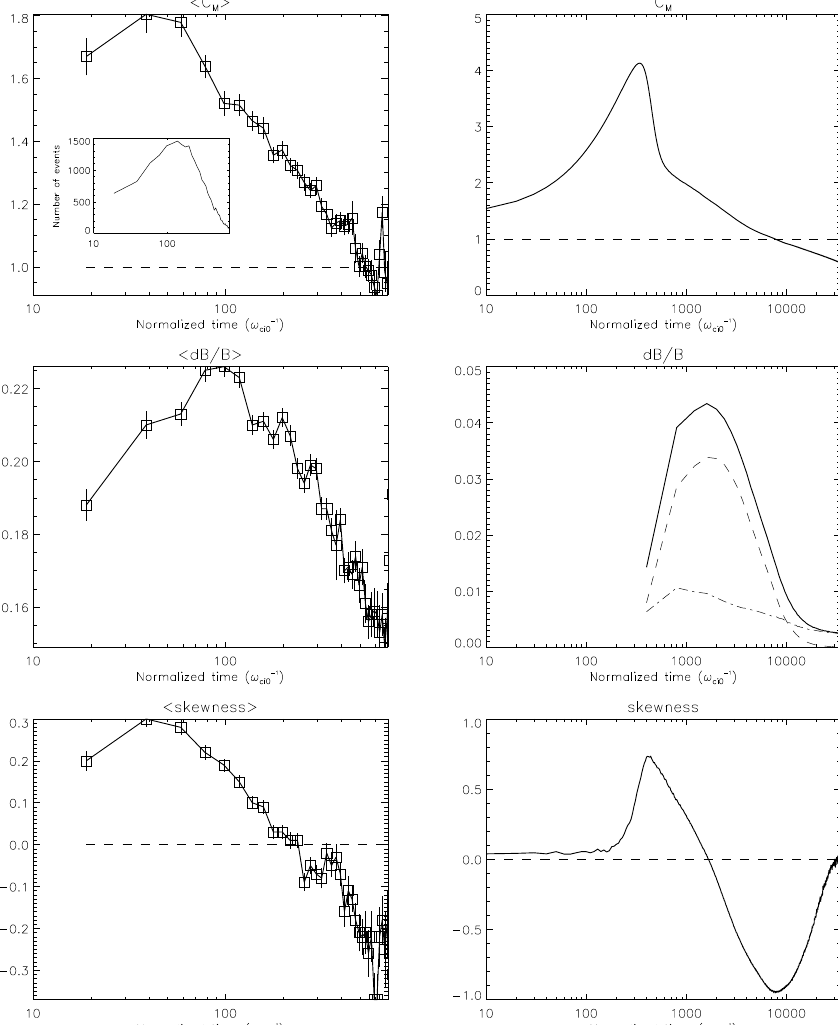
Fig. 4. Left column, observations. As a function of the normalized flow time: (top) median value of C m , (middle) median value of δB/B , (bottom) median value of the skewness. The error bars are proportional to σ/ √ N where σ is the standard deviation and N is the number of mirror events in each flow time bin ( ∆ t = 20). [Right column, simulation]. As a function of the normalized time, and averaged in the perpendicular to B direction: (top) C m , (middle) total δB/B (solid line), mirror contribution (dash line) and proton cyclotron contribution (dot-dash line), (bottom) skewness of parallel magnetic fluctuations. The insert shows the distribution of mirror events as a function of the normalized flowtime.